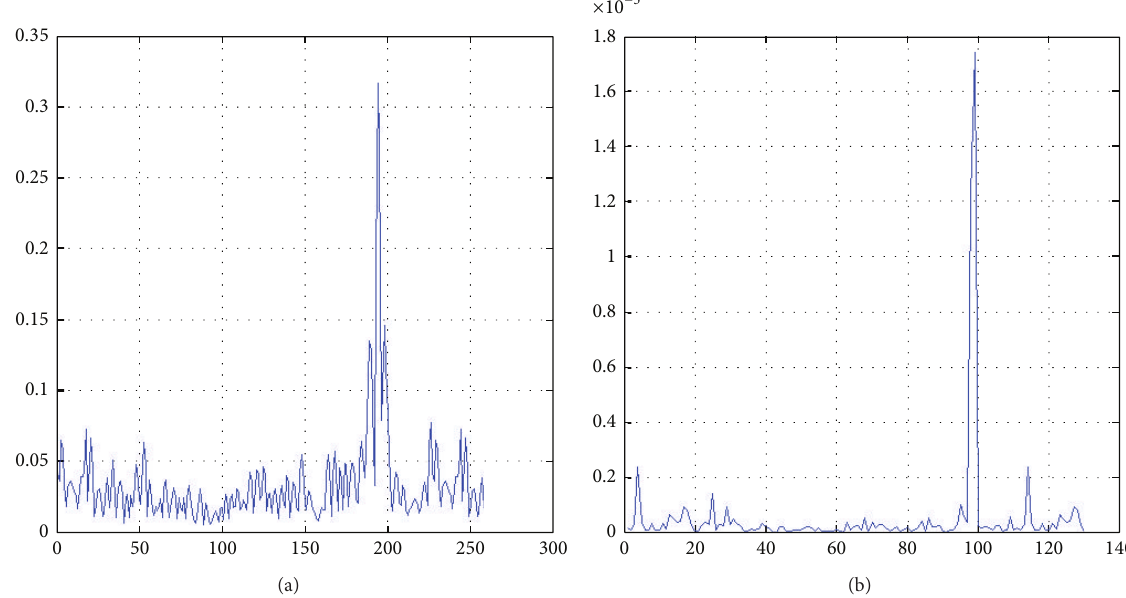
Figure 10: Benchmark results for SDI using isotropic CWT-based (a) and DTWT-based (b) algorithms with boundary effect removal.